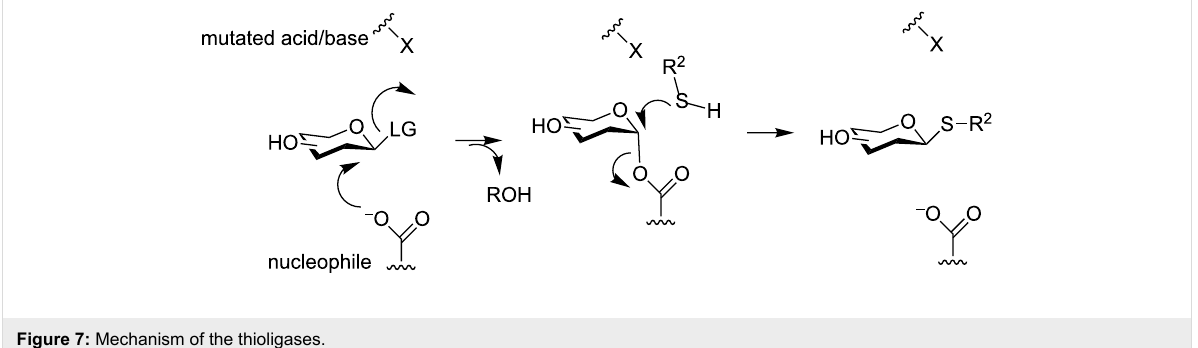
Figure 7: Mechanism of the thioligases.